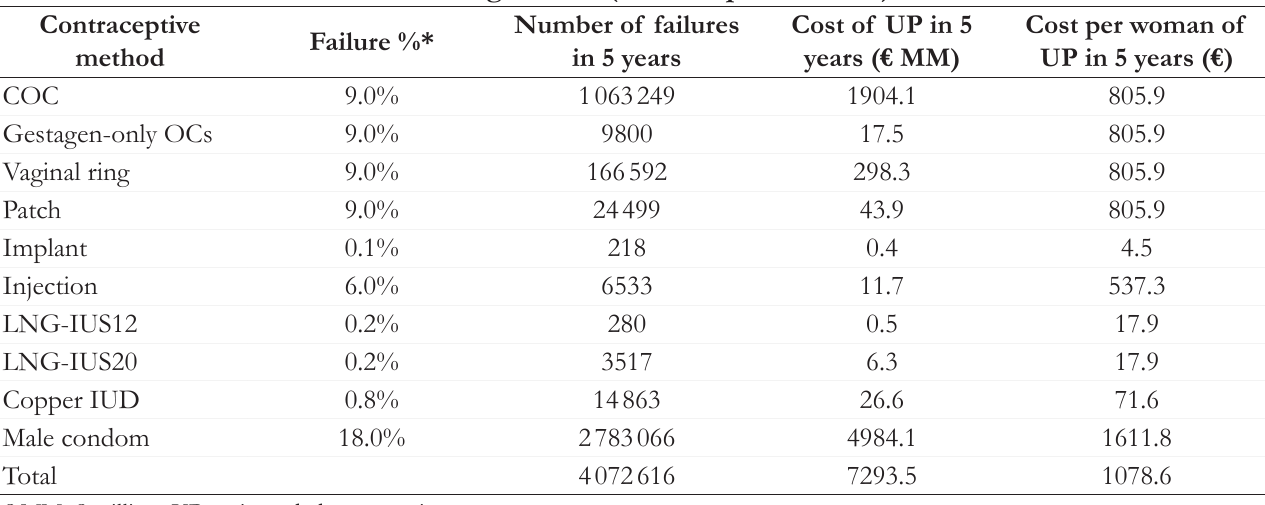
Table 6. Total Cost of Unintended Pregnancies (contraception